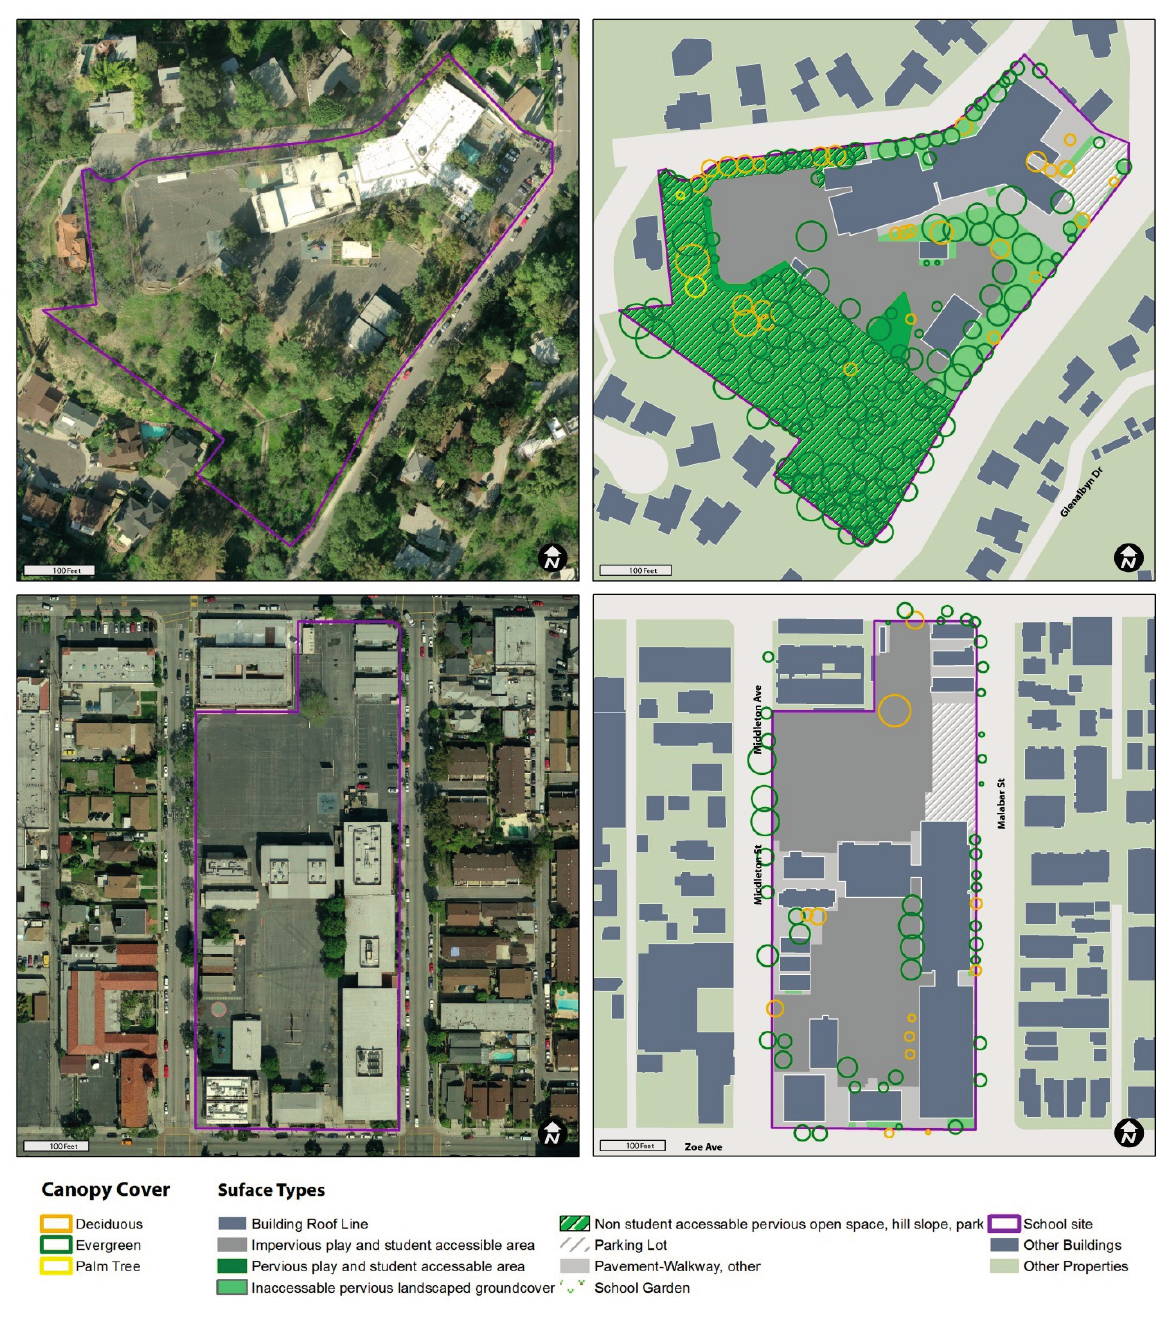
Figure 1. Top : Mt Washington Elementary showing hill slope. Bottom : Middleton Elementary in an urban